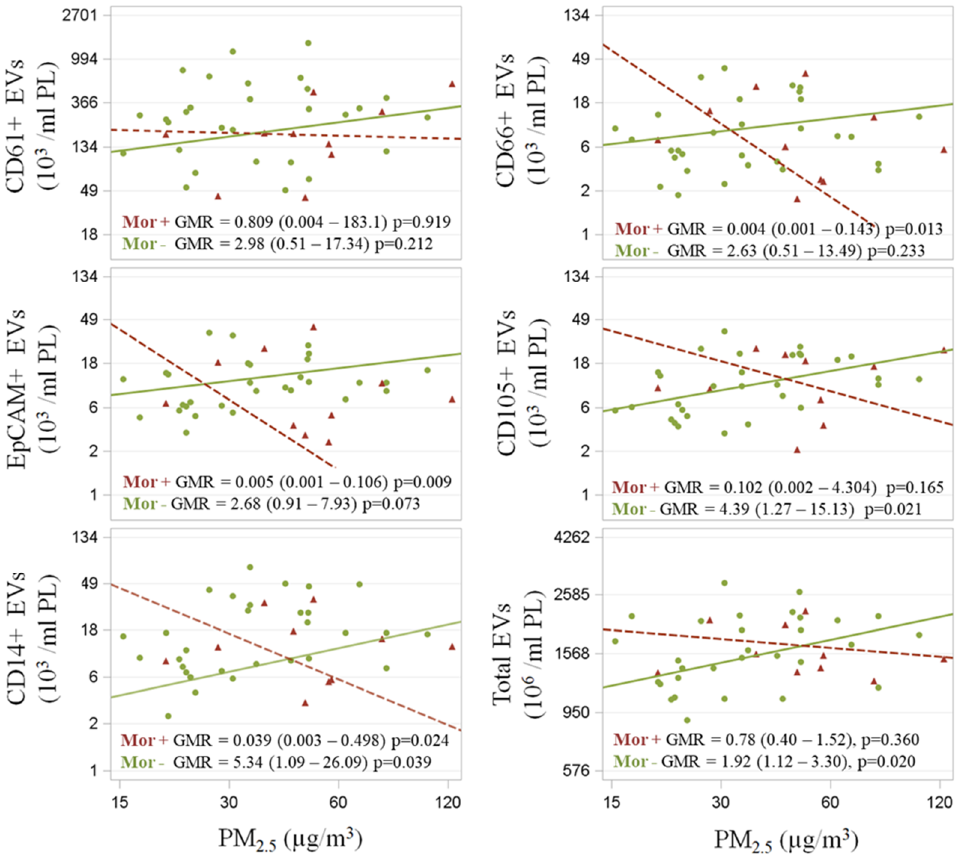
Figure 4. Association between EV outcomes and PM2.5 exposure. Mor + and Mor − subjects were represented by crosses and circles, respectively. Scatterplots of EV (103 / mL PL) vs. PM2.5 (below) levels ( µ g / m 3 ). Covariate-adjusted geometric mean ratios and corresponding 95% confidence intervals (GMR (95%CI)) in EV estimated per log10-unit increase in PM are shown. Subjects were stratified according to their Moraxella genus relative abundance into the Mor − ( ≤ 25%) and Mor + ( > 25%) group. Total EV count obtained via nanoparticle tracking analysis (NTA). EV fraction counts performed via flow-cytometry (FC)